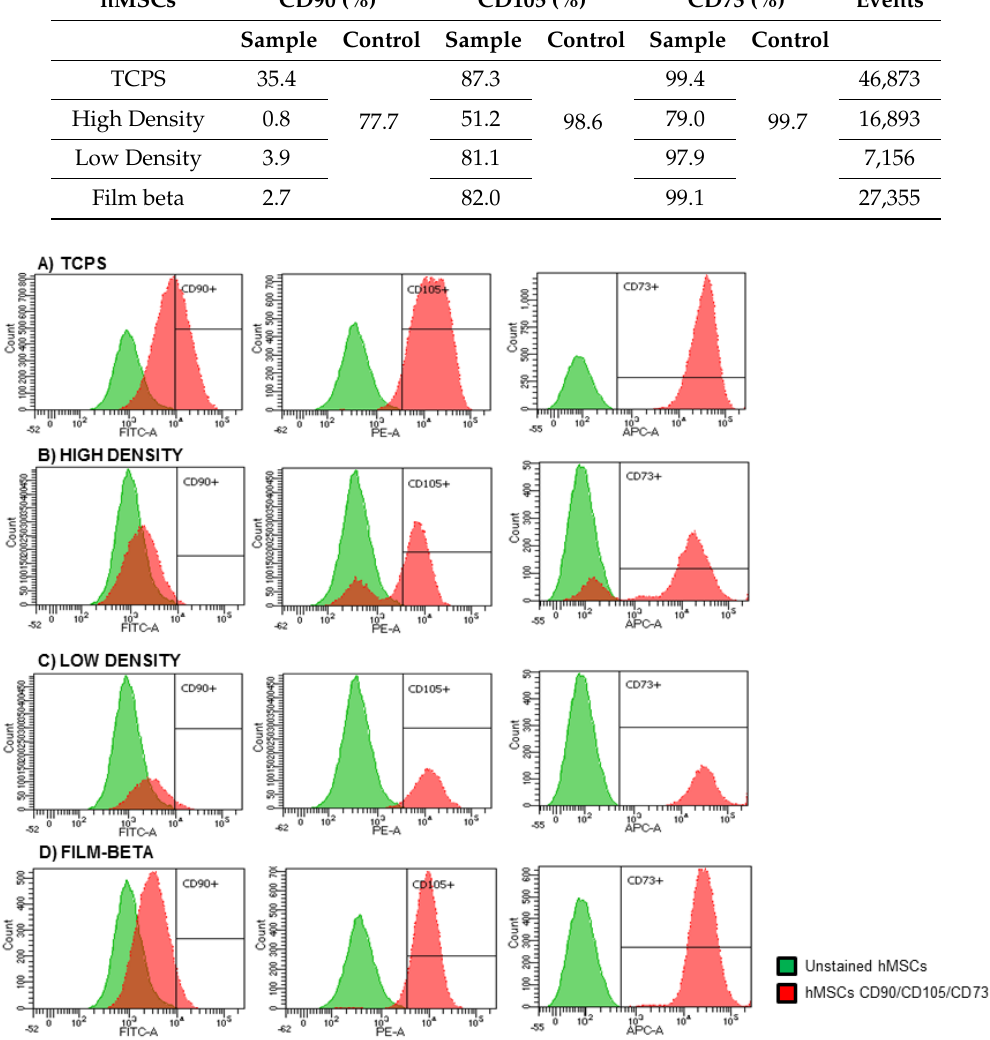
Figure 4. Flow cytometry histograms of merged samples of the unstained and stained hMSCs cultured at day 4 on ( a ) tissue culture polystyrene (TCPS); ( b ) low density of microparticles (LD-M) film; ( c ) high density of microparticles (HD-M) film; and ( d ) film-beta. Fluorescein isothiocyanate (FITC): CD90; phycoerythrin (PE): CD105; allophycocyanin (APC): CD73.